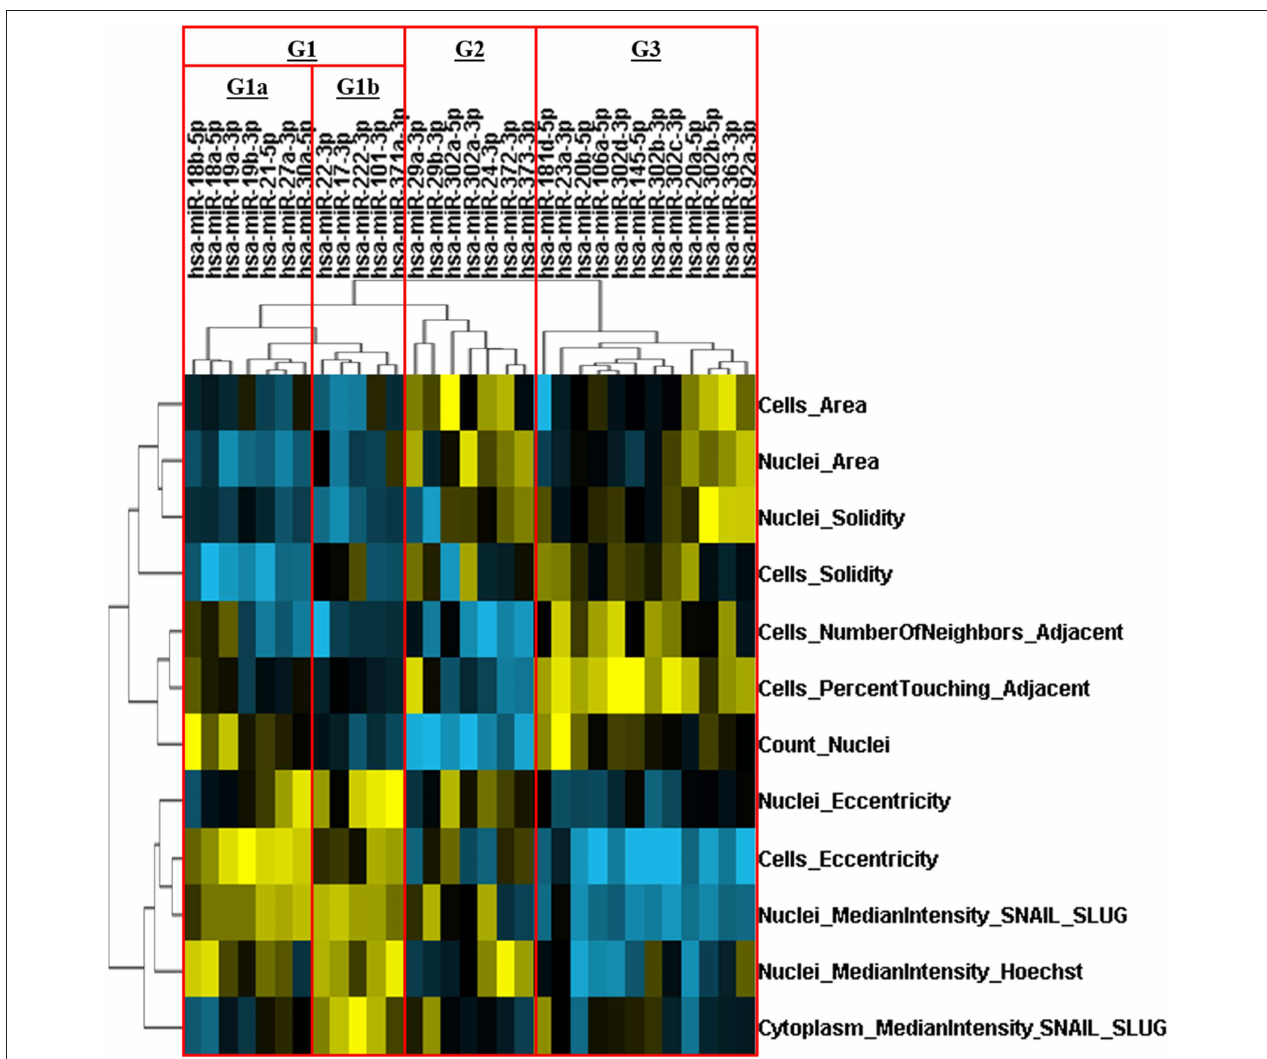
FIGURE 5 | Hierarchical clustering of miRs based on their effects on multiparametric phenotypic alterations. The FADU cell line was transfected with human miRs mimics, for 24h, followed by stimulation with TNF- α (20ng/mL) for 72h. After immunostaining with antibodies against Snail/Slug (SN/SL) and co-staining with nuclear (Hoechst) and cytoplasmic (CellMask) dyes, images were acquired with an ImageXpress Micro XLS HCS system (Molecular Devices), using a 10X objective and excitation/emission filters DAPI (Hoechst), FITC (SN/SL), and Cy5 (CellMask Deep Red). With aid of CellProfiler, we evaluated several morphometric parameters, besides cell quantity (count nuclei) and the presence/location of Snail/Slug. Multiparametric phenotypic profiles, describing the effects of each miR, were obtained and subjected to an unsupervised hierarchical cluster analysis. Heatmap showing the multiparametric phenotypic profiles induced by each miR, and the four groups of miRs identified (G1a, G1b, G2, and G3. Red rectangles). Increase and decrease relative to PMC are depicted in yellow and blue,